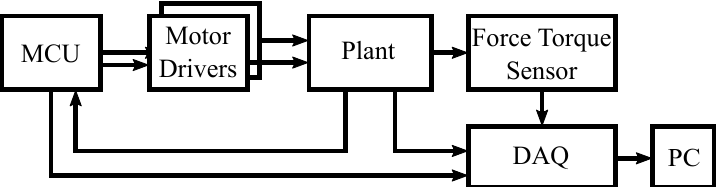
Figure 11. The microcontroller unit (mcu) provides the digital and PWM signals to the motor drivers, driving the plant. The MCU measures the feedback from the plant and provides an analog of the plant state and control system command to the DAQ which also records the forces generated by the plant. The controlling PC records all the information collected.